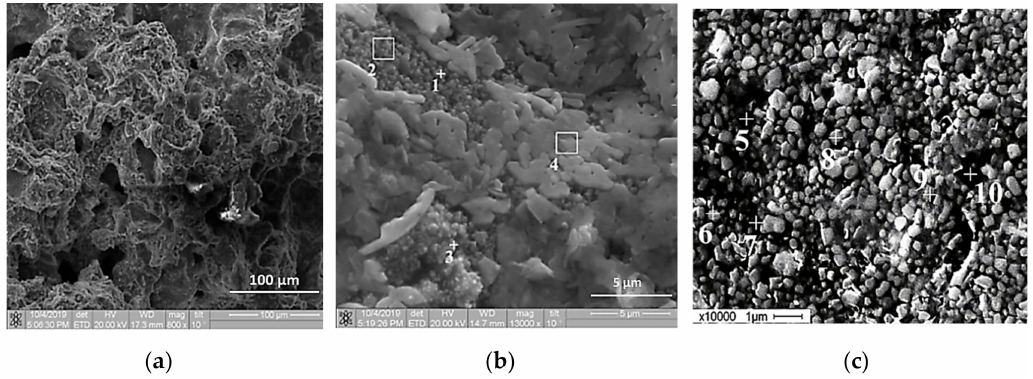
Figure 11. SEM images of self-propagating high-temperature synthesis (SHS) product: ( a ), ( b ) cross-section; ( c ) polished and etched surface.